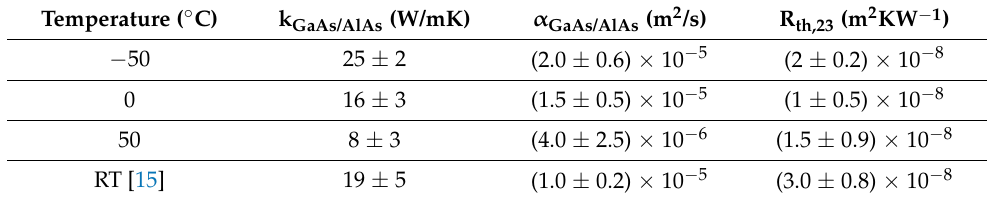
Table 3. Cross-plane thermal transport parameters of the AlAs/GaAs superlattice, obtained from fits to the PTR data in Figure 5 for different temperatures.